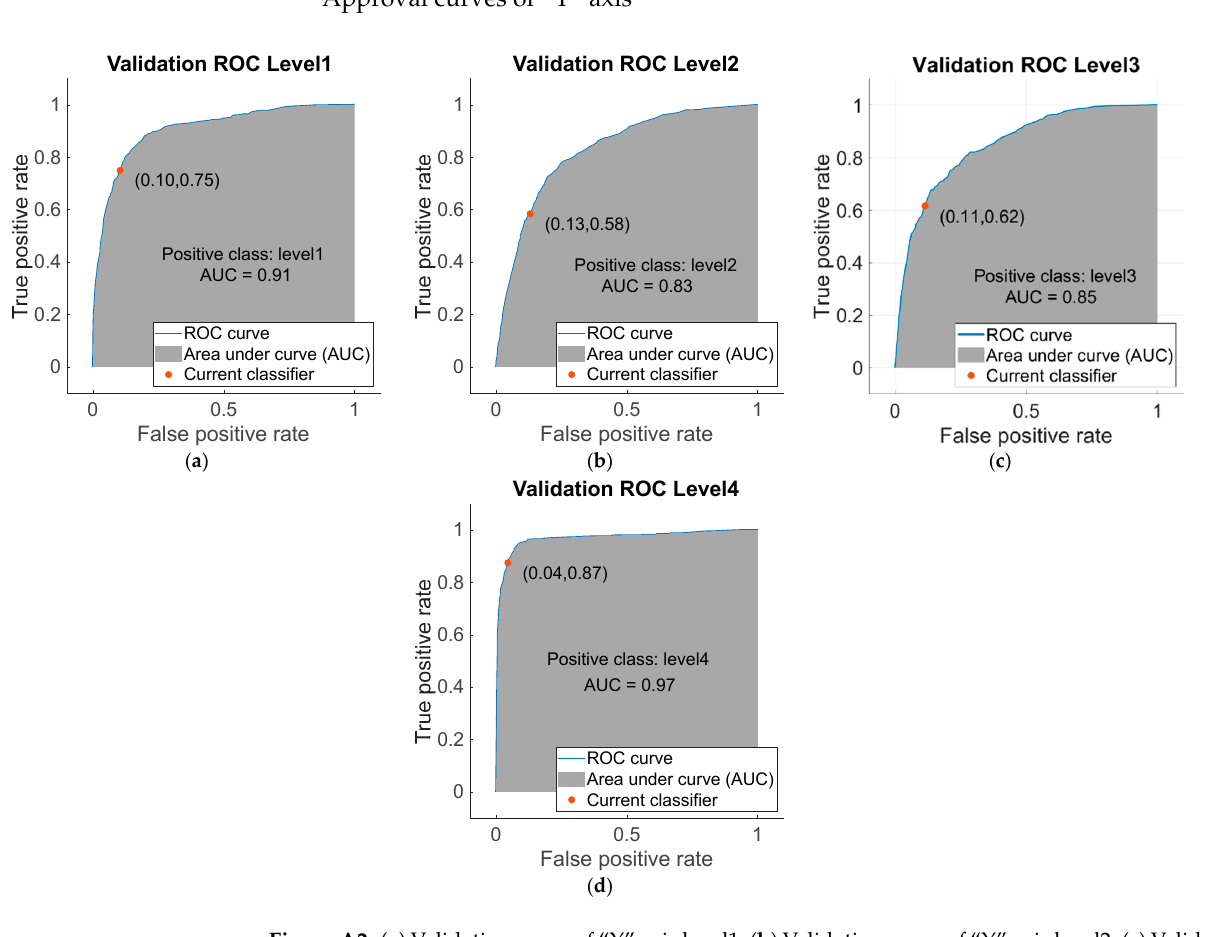
Figure A2. ( a ) Validation curve of "Y" axis level1; ( b ) Validation curve of “Y” axis level2; ( c ) Validation curve of “Y” axis level3; ( d ) Validation curve of “Y” axis level4.